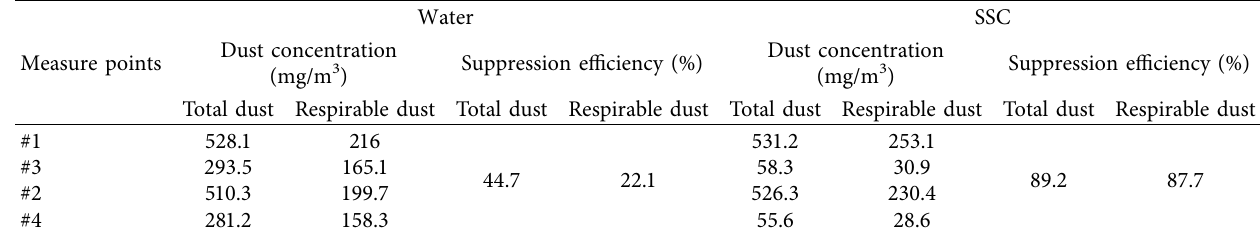
Table 1: Suppression efficiency rates under the different